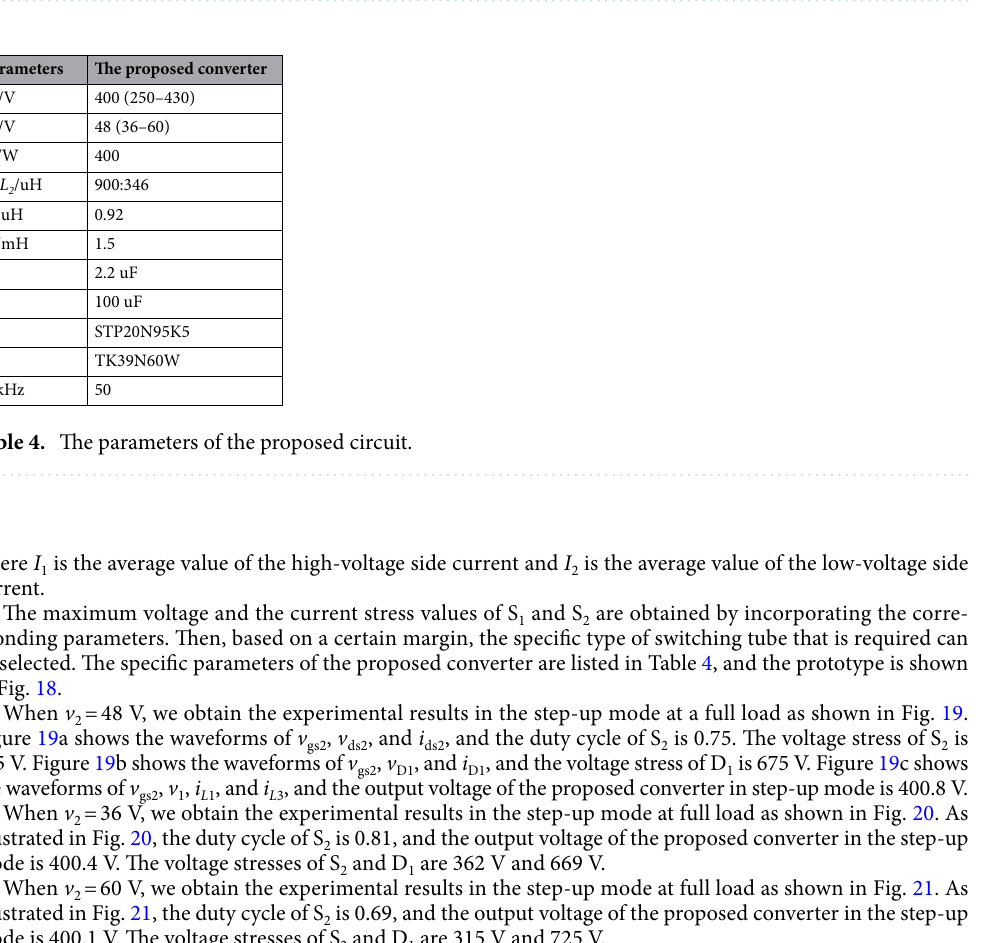
Figure 17. The stable waveforms of the key components in the step-down mode.